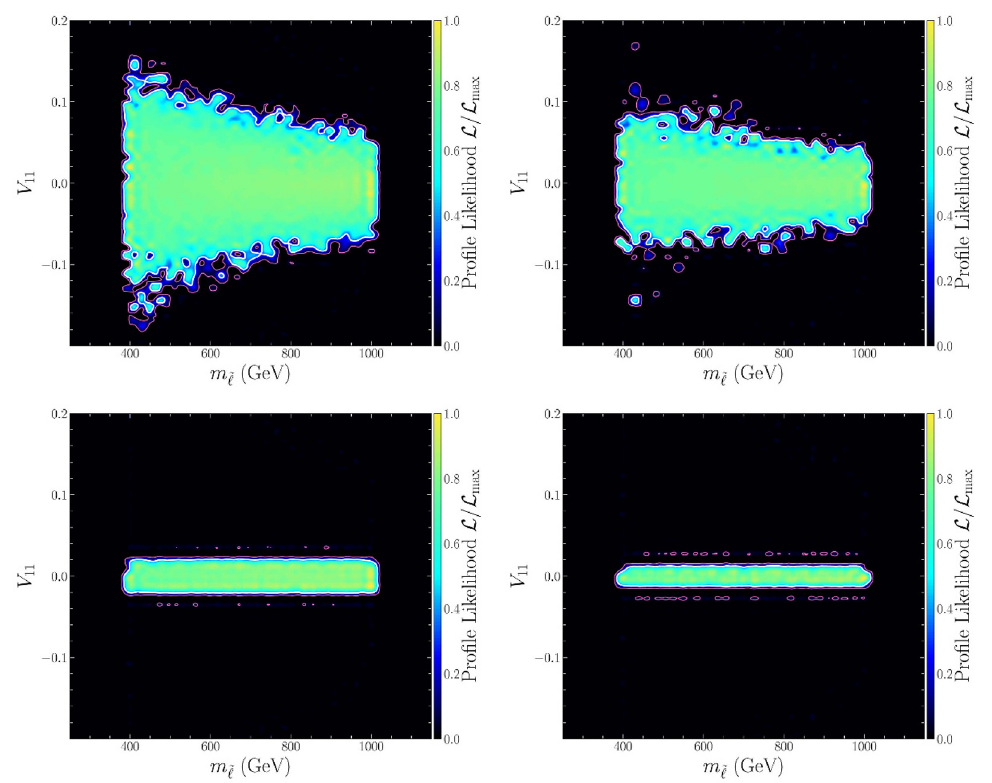
Figure 10 . Same as figure 5, but for the massive h s scenario defined in table